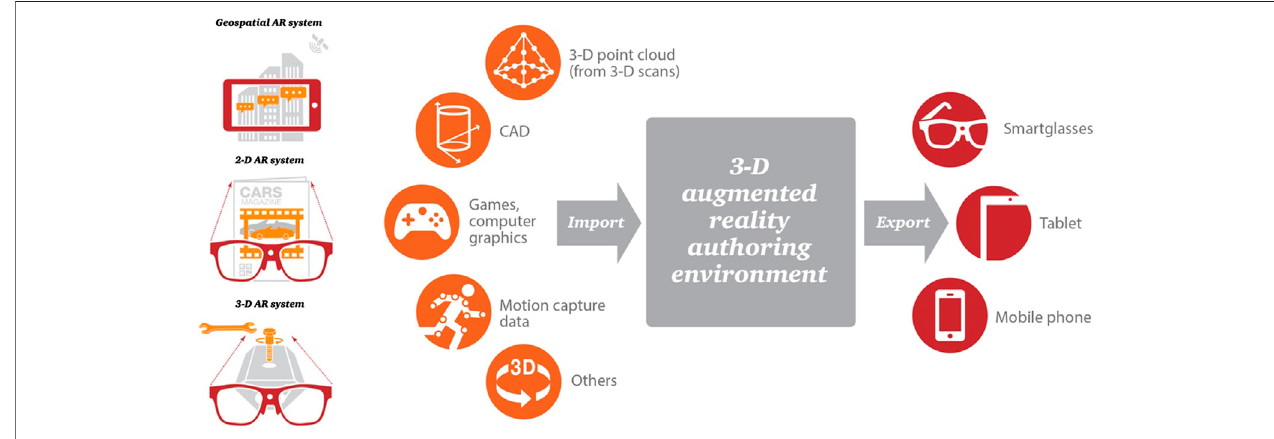
FIGURE 8 | AR solutions (hardware and software possibilities) (PWC, 2019).